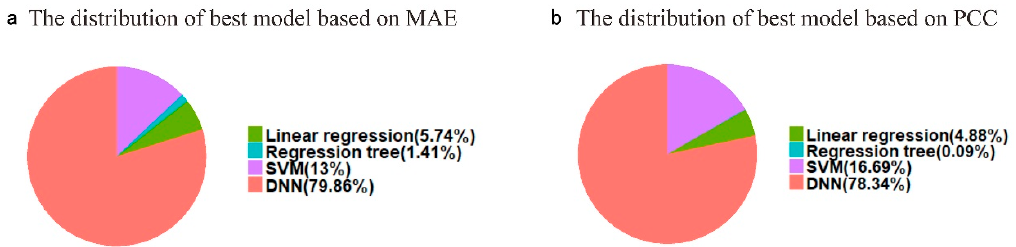
Figure 6. Distribution of the best model. ( a ) Distribution of the best model according to MAE for the target genes. ( b ) Distribution of best model according to PCC for the target genes.